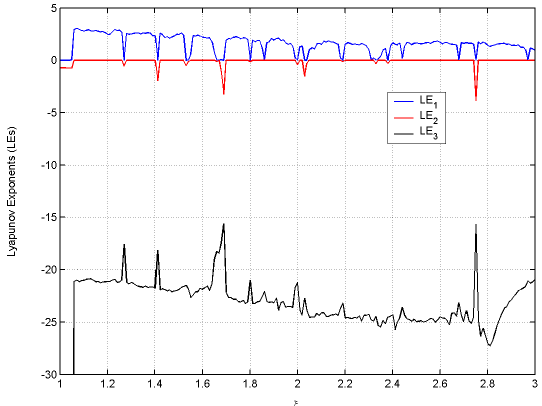
Figure 1. The spectrum of the Lyapunov exponents of system (3).